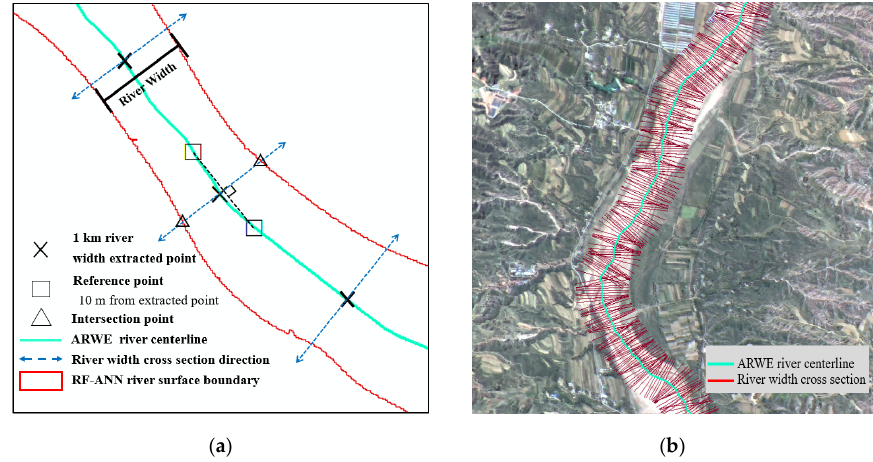
Figure 6. Key steps and illustration of the river width cross sections. ( a ) Method for determining the direction of river width and calculating the river width at the river width extracted points. ( b ) Schematic diagram of the river width cross section at the extracted points.